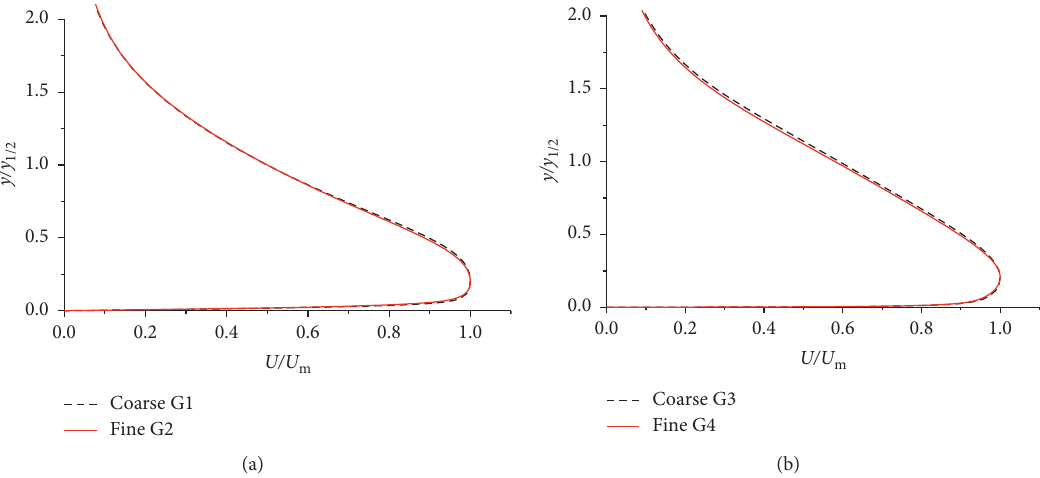
Figure 2: Grid independence study for: (a) radial wall jet, r � 1.5 D and (b) plane wall jet, x � 30 b Table 2: Simulation cases for radial wall jet. Cases